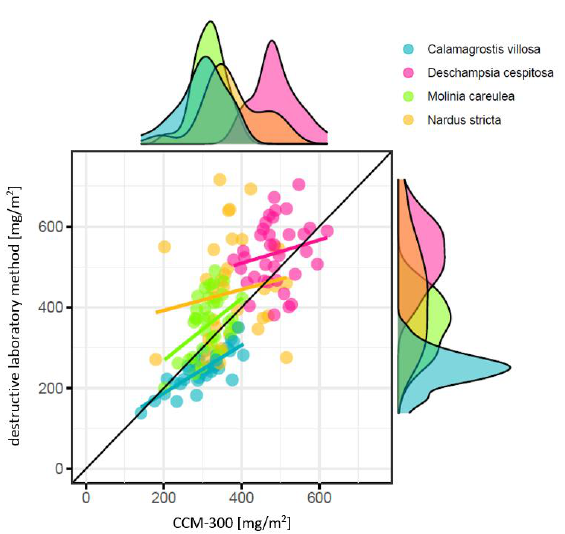
Figure 3. Leaf chlorophyll content values measured with CCM-300 chlorophyll meter in the field and determined biochemically in the